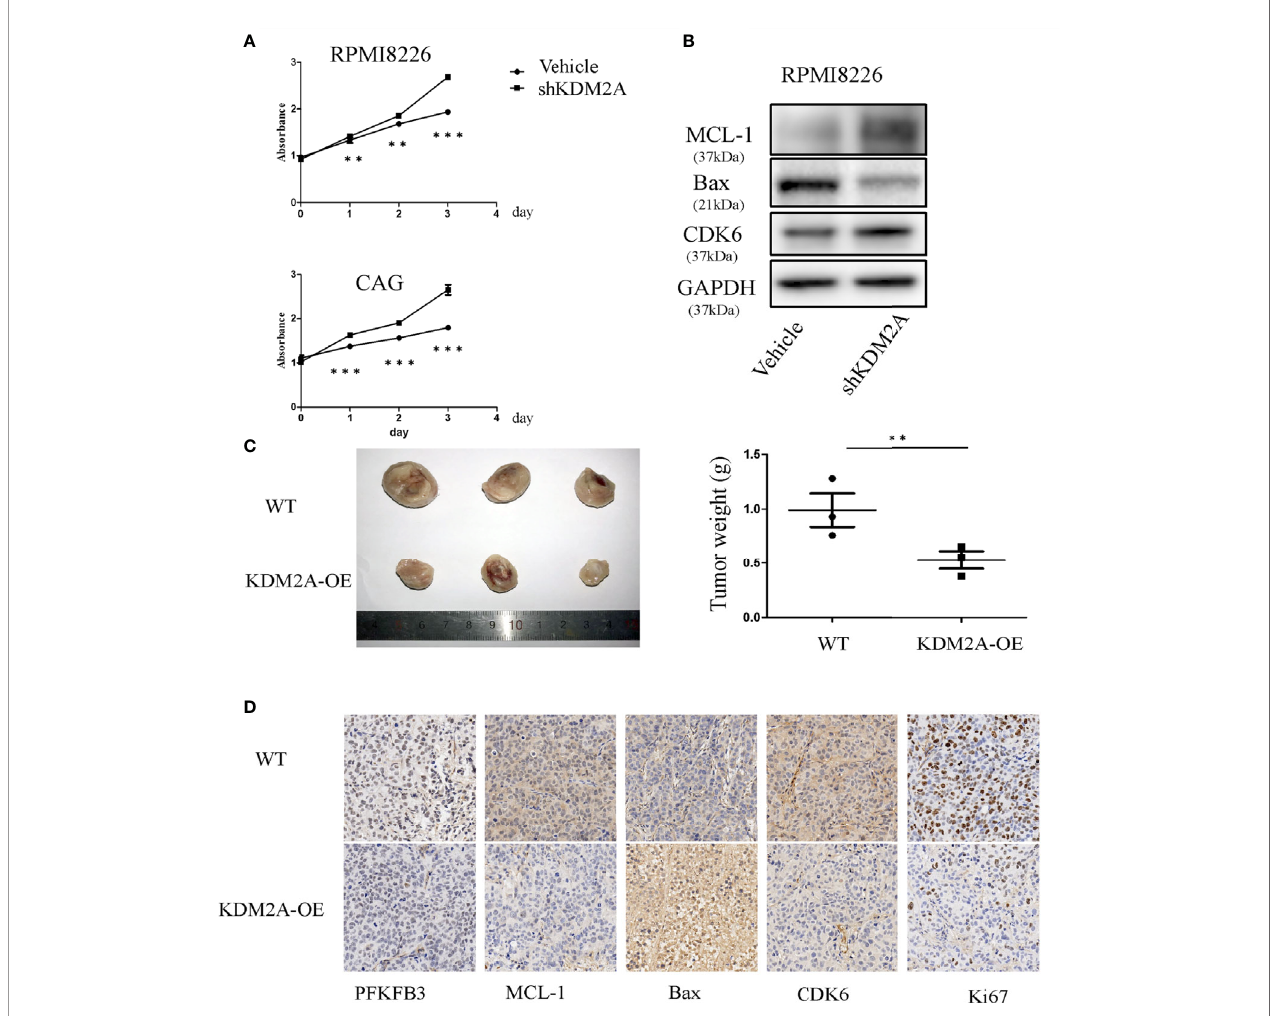
FIGURE 2 | KDM2A mediates MM cell proliferation. (A) Proliferation of RPMI8226 and CAG cells was determined by CCK-8 assay after shKDM2A transfection. The results are representative of three independent experiments. (B) Knocking down of KDM2A decreased the expression of Bax and increased MCL-1 and CDK6 in MM cells by Western blot analysis. GAPDH was used as loading control. (C) Photographs of tumor masses were shown on the left panel and the tumor weight was measured and shown on the right panel after excised 3 weeks inoculation of CAG cells with KDM2A-WT or KDM2A-OE into NOD-SCID mice. (D) Immunohistochemistry staining for tumor tissue from KDM2A-WT and KDM2A-OE NOD-SCID Mice. (*P < 0.05, **P < 0.01, ***P < 0.005, data were represented as mean ±